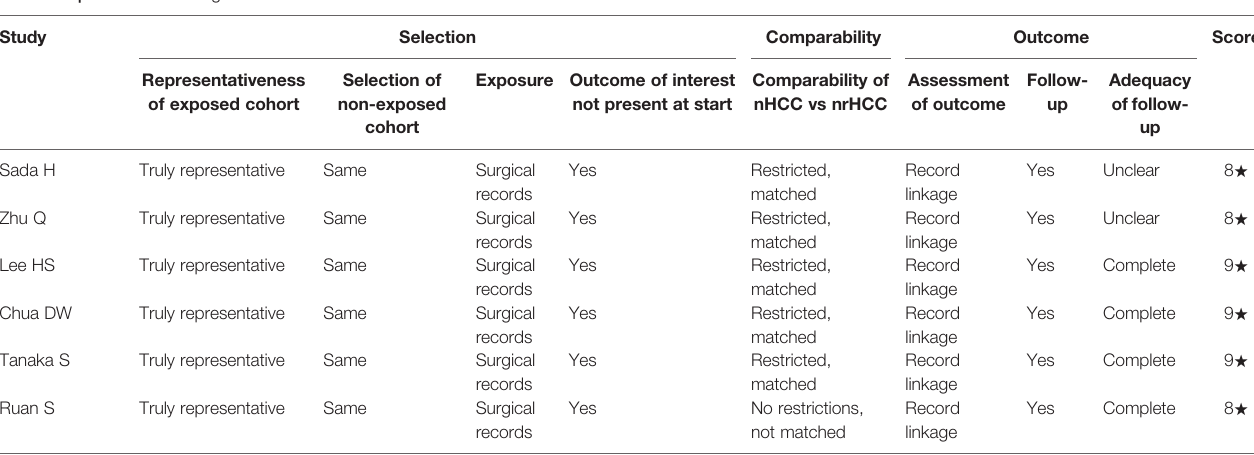
TABLE 3 | Risk of bias using the modi fi ed Newcastle-Ottawa